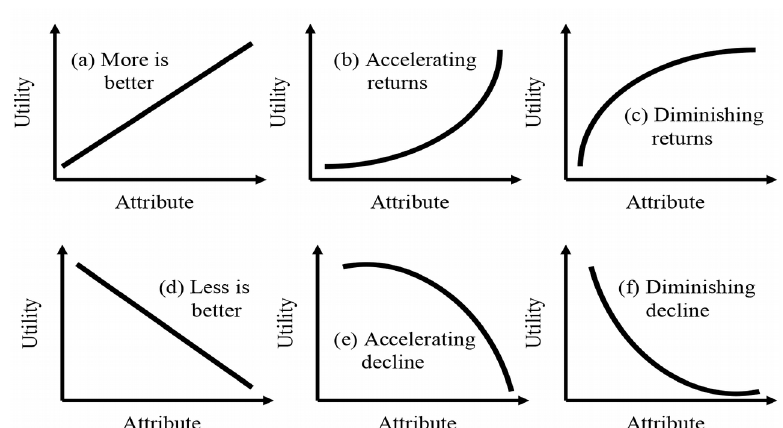
Figure 4. Utility functions